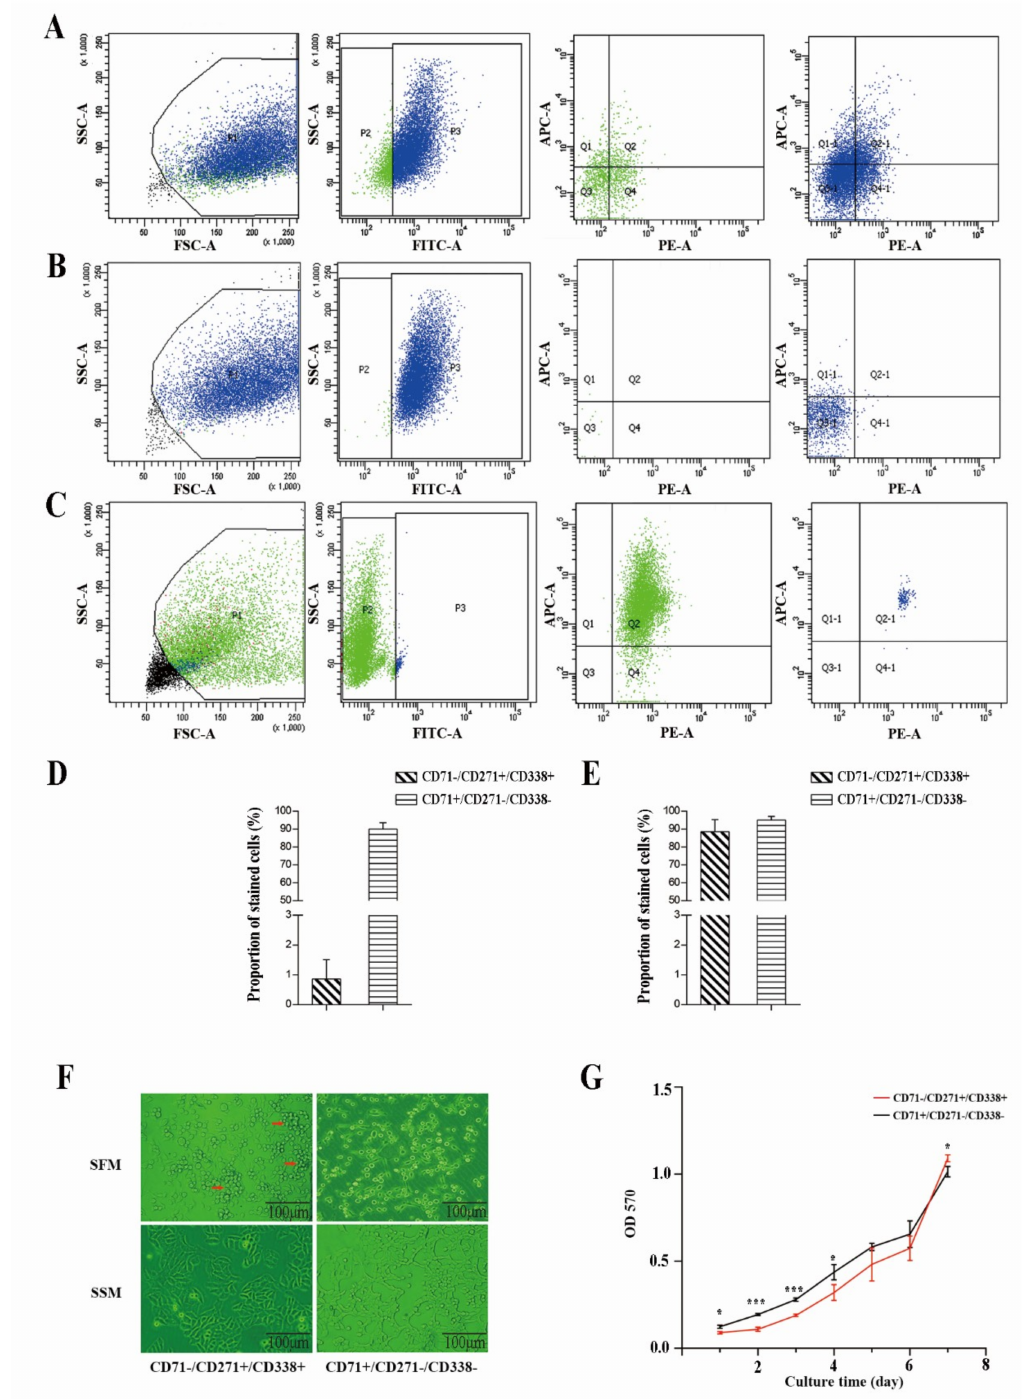
Figure 2. Combination of CD71 − , CD271 + , and CD338 + can be used for isolating cancer stem cells (CSCs) in ESCC. ( A ) Expression of CD71, CD271, and CD338 in Eca9706 in multiple stained cells. ( B ) Expression of surface markers in CD71 − / CD271 + / CD338 + cells just after sorting. ( C ) Expression of surface markers in CD71 + / CD271 − / CD338 − cells just after sorting. ( D ) Positive rate of CD71 − / CD271 + / CD338 + and CD71 + / CD271 − / CD338 − cells in Eca9706 for sorting. ( E ) Recovery rate of sorted CD71 − / CD271 + / CD338 + and CD71 + / CD271 − / CD338 − cells. ( F ) Growth status of the two subpopulations of cells in serum-free-DMEM-F12 medium (SFM) and serum-supplied medium (SSM). ( G ) Growth curve of the two subpopulations of cells in SSM. t -Tests (independent samples) were used to compare the results between two groups: * p < 0.05, *** p <